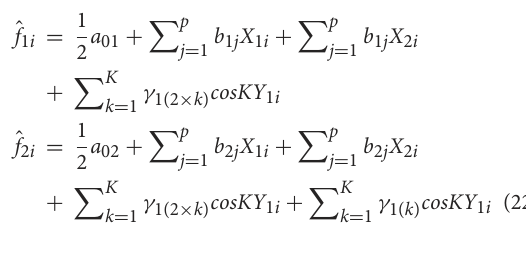
When translated, equation Fourier series and smoothing spline is shown in the equation